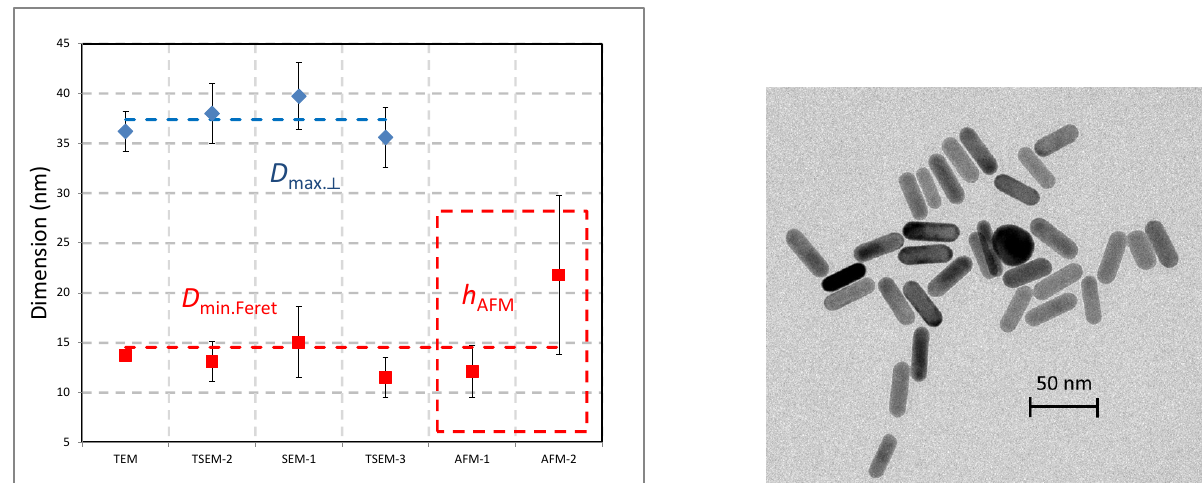
Figure 14. ( Left ) Size measurements of the nPSize07 material (Au nanorods) performed by different techniques and laboratories. ( Right ) Representative gold nanorods imaged by TEM. The uncertainty bars (k = 2) are also given with the mean values.